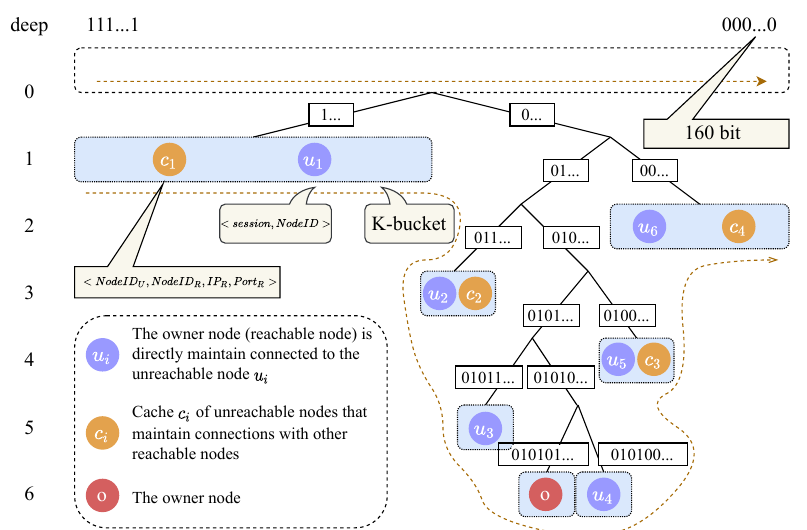
Figure 10. The k-bucket of reachable nodes represented using a binary tree. There are three types of nodes in the k-bucket, which are represented by three colors. For clarity of presentation, not all of the 160 bit address space is